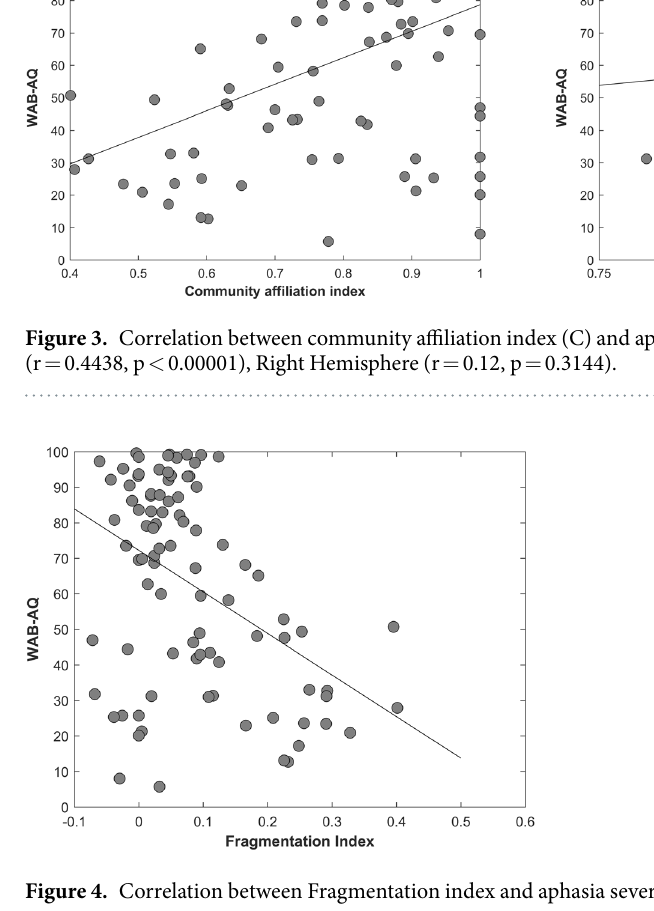
Aphasia severity and community affiliation index was not significantly correlated when controlling grey or white matter damage. There right hemisphere community affiliation index was not significantly correlated with WAB-AQ (Fig. 3 right panel).